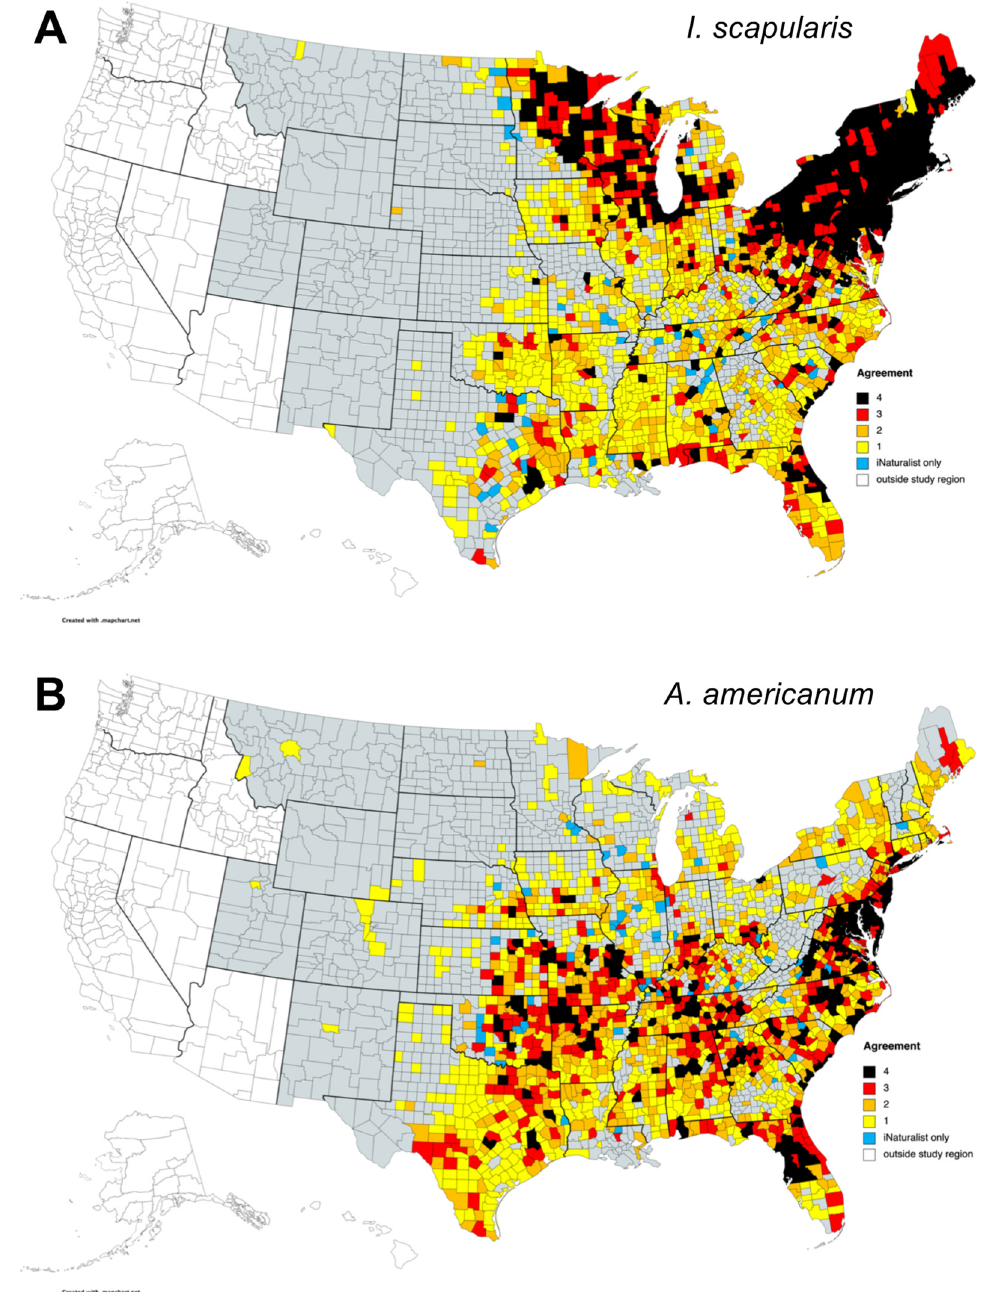
Figure 4. Comparison of recorded United States county-level distribution of ( A ) Ixodes scapularis and ( B ) Amblyomma americanum between iNaturalist data and recent sources of US-wide tick surveillance data Refs. [6,8,31,38,45,72]. The number of surveillance methods reporting tick presence in each county is indicated by the color. [72] includes data from the ArboNET Tick Module. Maps created with mapchart.net. Raw data are available in Table S3.